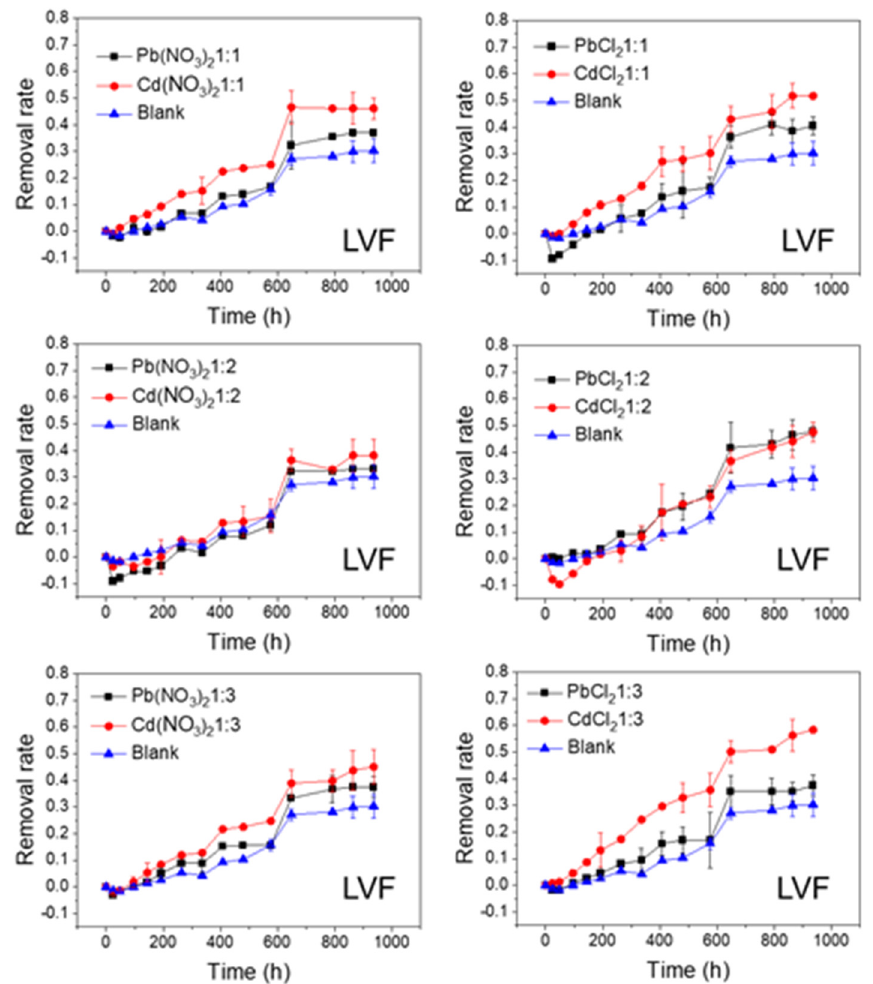
Figure 3. Photolytic degradation of LVF (0.012 mmol/L) with the effects of Pb 2+ and Cd 2+ at different molar ratios; Blank means no heavy metal ions added.